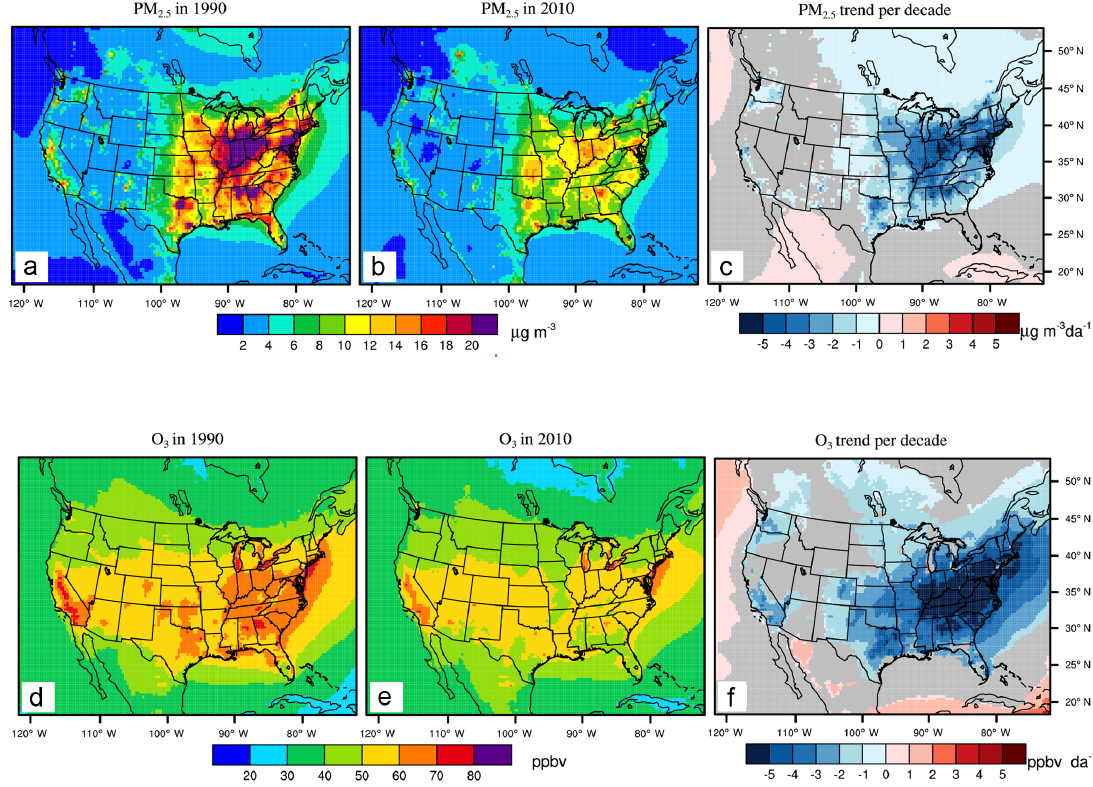
Figure 1. Annual mean PM 2 . 5 ( µgm − 3 ) in 1990 (a) and 2010 (b) , and the 21-year trends ( c , µgm − 3 decade − 1 (µgm − 3 decade − 1 )) and summertime average of 1h daily maximum O 3 in 1990 (ppbv) (d) and 2010 (e) , and the trend ( f , ppbvdecade − 1 (ppbvdecade − 1 )). The grey shaded areas in panels c and f indicate trends that are insignificant with p -values for the standard Student’s t test larger than